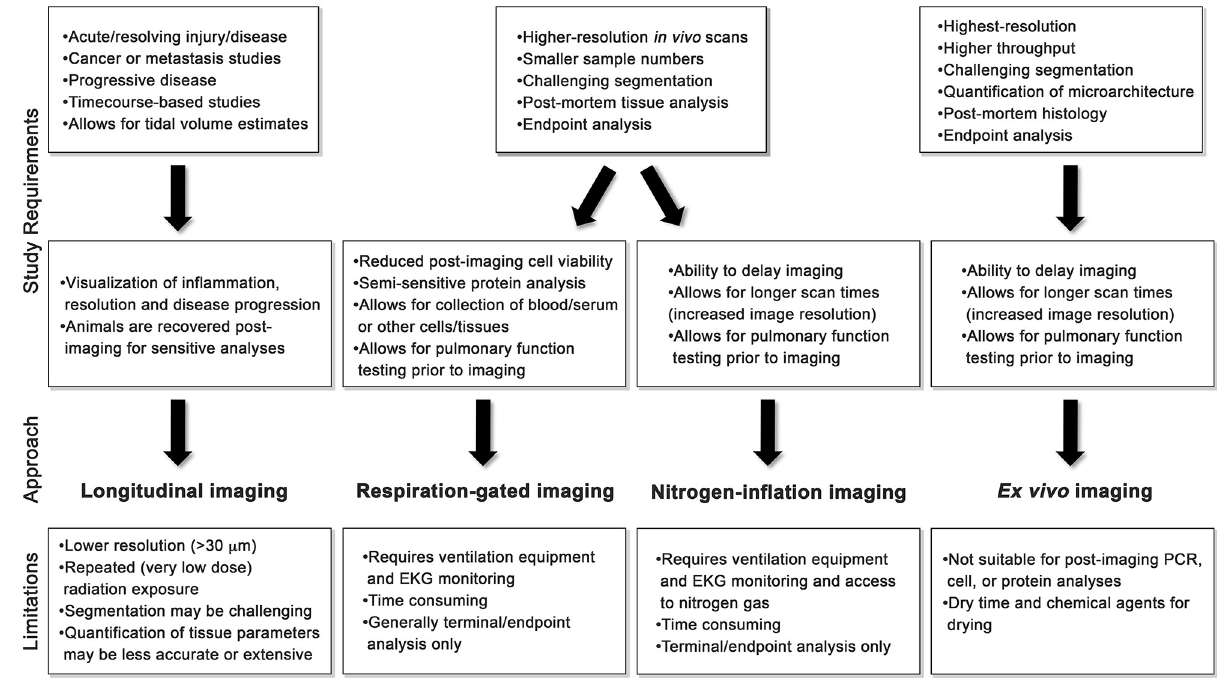
Fig 6. Summary and considerations of imaging modalities. A flow chart of assessment for study requirements to determine the appropriate imaging approach and associated limitations for: longitudinal-, respiration-gated-, nitrogen-inflation- and ex vivo -imaging.